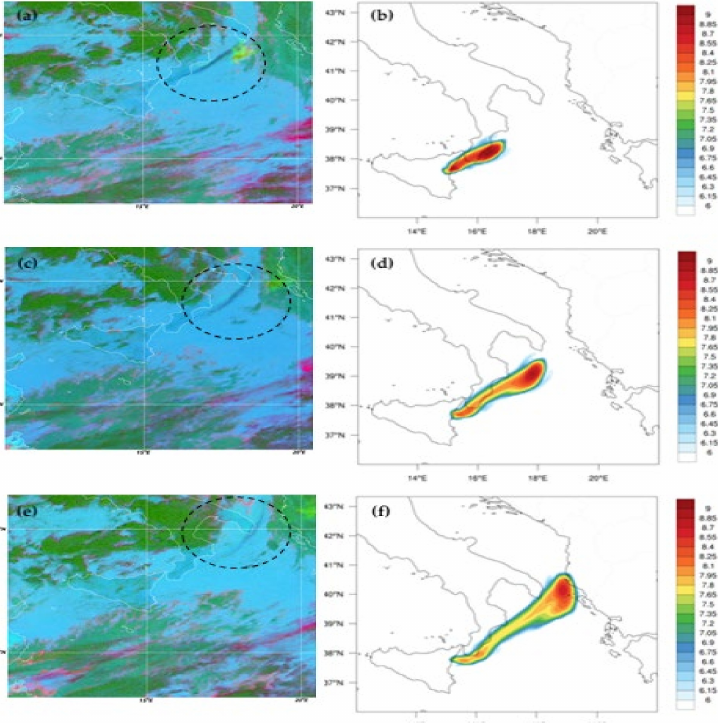
Figure 11. Snapshots of Etna’s volcanic ash plume at 11:00 UTC (upper row), 12:00 UTC (central row), and 13:00 UTC (lower row) on 23 November 2013. Panels ( a , c , e ) represent RGB composite images from MSG SEVIRI (HOTVOLC), with detected volcanic ash in blue within the area highlighted by the black dotted line; panels ( b , d , f ): WRF-Chem model outputs from run2 configuration with time-varying ESP showing columnar ash mass density ( µ g m − 2 , in Log 10